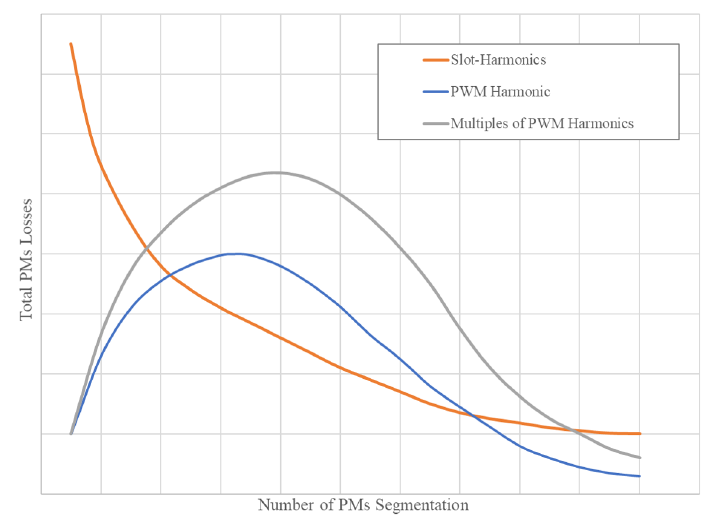
Figure 1. Permanent-magnets eddy current losses profiles as a function of magnet segmentation. The orange curve represents the profile of low-frequency harmonics and blue and grey curves represent the profile of high-frequency harmonics